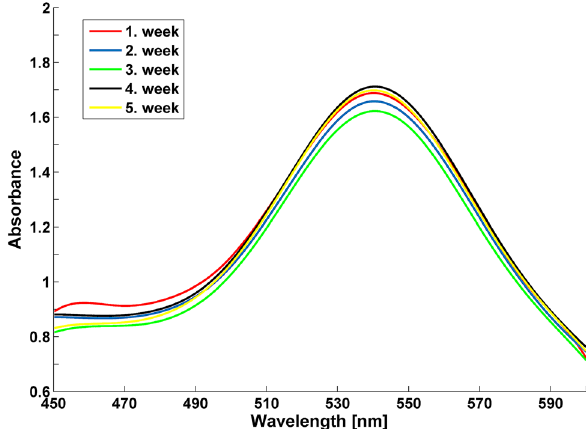
Figure 2. UV–VIS spectra of Au1 sample measured over 5 weeks.